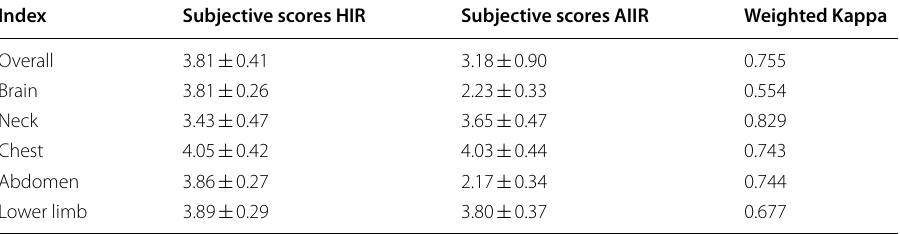
Table 2 Inter-rater consistency in the subjective assessment of the image qualities among the anatomical structure